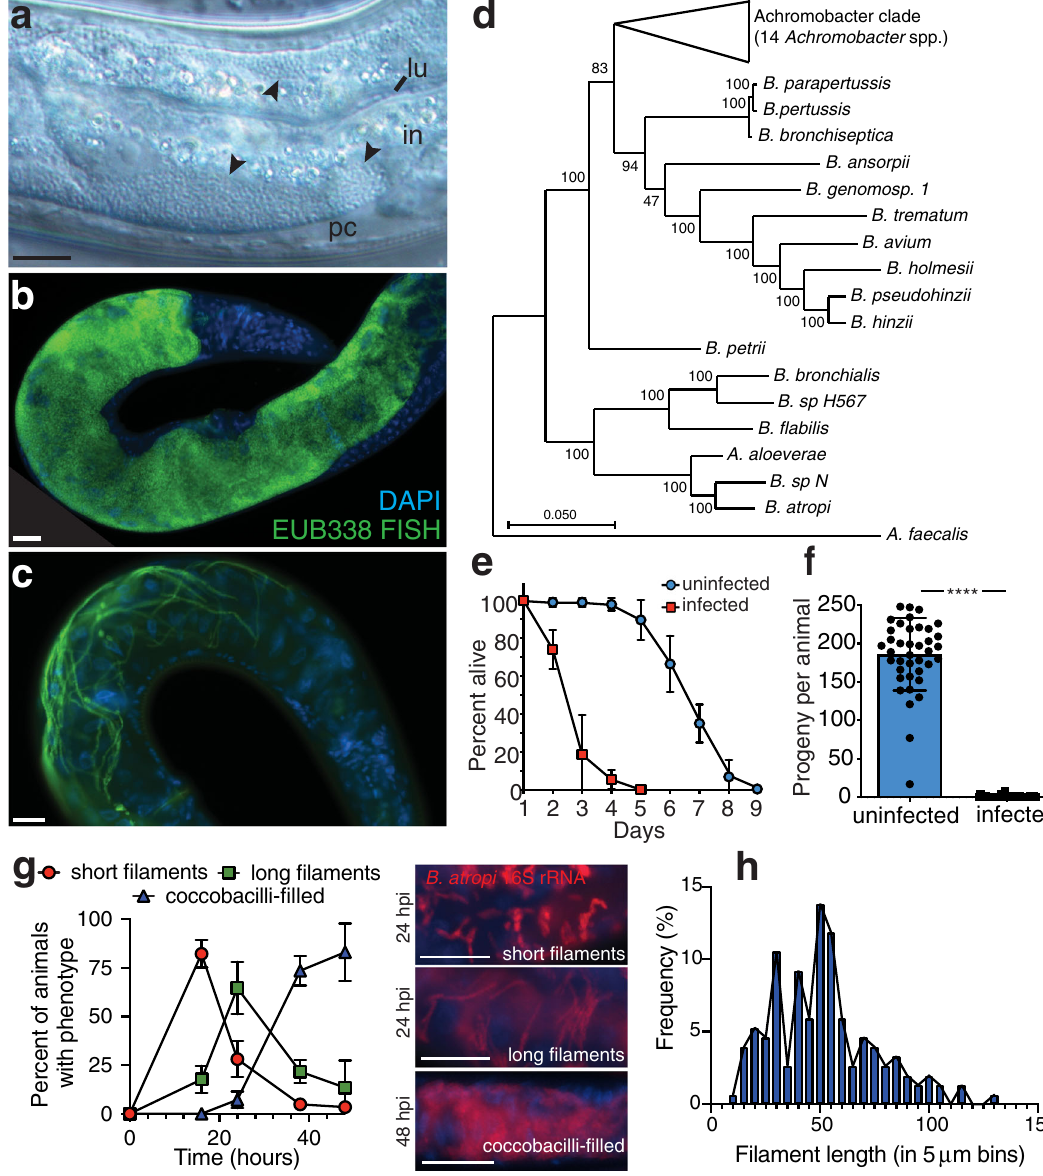
Fig. 1 Discovery and characterization of B. atropi infection in O. tipulae . a A multitude of coccobacilli (arrowheads) inside the intestinal cells (in) of O. tipulae strain JU1501. The intestinal lumen (lu) and pseudocoelom (pc) are indicated. b, c FISH using a universal bacterial 16S rRNA probe EUB338. Different animals shown from the same plate. Scale bars are 20 μ m. d Phylogenomic tree of sequenced Bordetella and Achromobacter spp. with outgroup Alcaligenes faecalis . Branch lengths are the number of substitutions per site and branch points indicate percentage of trees with clustering of associated taxa. e Lifespan of JU1501 infected or uninfected with B. atropi , n = 20 animals in 3 independent experiments. Points represent mean values and error bars represent standard deviation (SD). f Broodsizes of JU1501, **** is p < 0.0001 by unpaired, two-tailed t -test with Welch ’ s correction, n = 20 animals in 2 independent experiments. Error bars indicate SD and each point represents number of progeny from a single animal. g Pulse-chase infection time course, n = 857 animals binned over 2 independent experiments, error bars represent SD. Representative infection phenotypes are shown. Scale bars are 20 μ m. h Histogram of in vivo fi lament lengths at 34 unseptated with regularly spaced nucleoids (Fig. 2f, g). TEM only captures a portion of a fi lament length due to thin sectioning and the longest fi lament captured with this method was 10.06 μ m (Fig. 2g), as compared to the average fi lament length of 51.86 μ m as determined by tracing individual distinguishable fi laments by emergence of phenotypes in vivo via fl uorescence microscopy (see are heavily infected with individual coccobacilli cells (Fig. 2h).